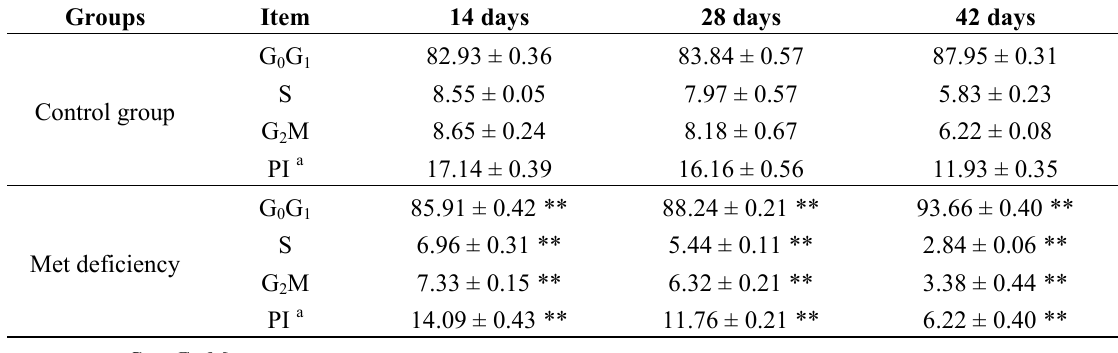
Table 3. Effect of Met deficiency on cell cycle phase distribution of bursae of Fabricius.